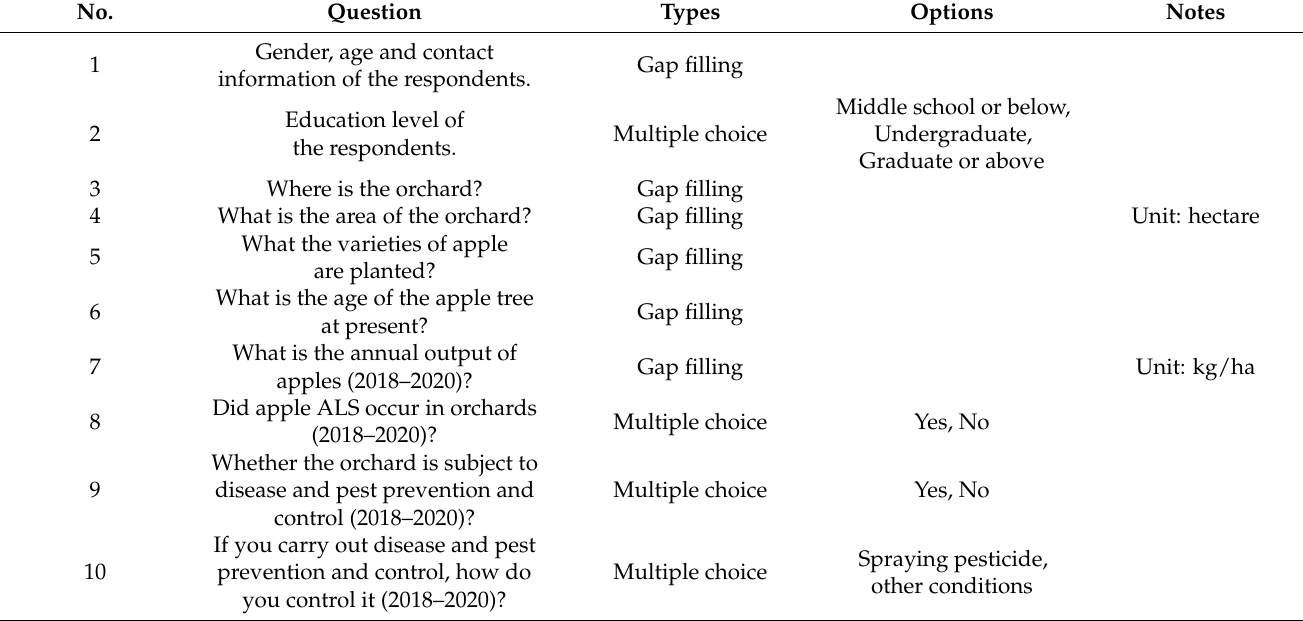
Table 1. Summary of questions in the mobile internet-based survey